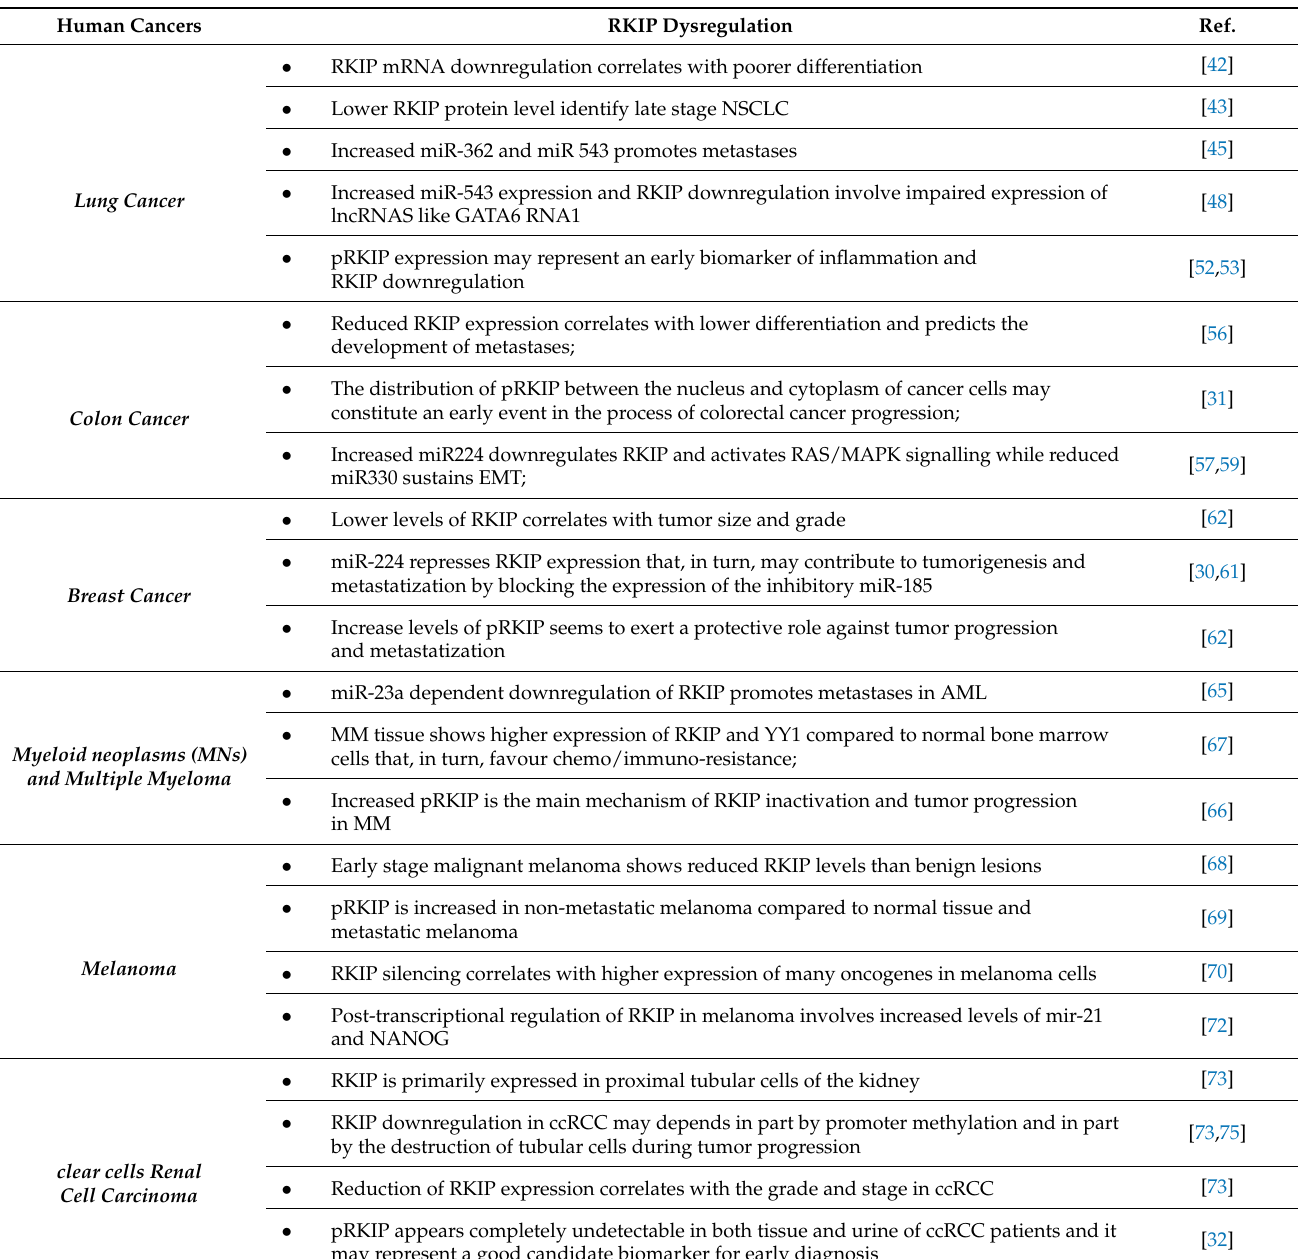
Table 1. Main contribution of epigenetic, post-transcriptional and post-translational regulation of RKIP in the onset and progression of human cancers. RKIP Dysregulation